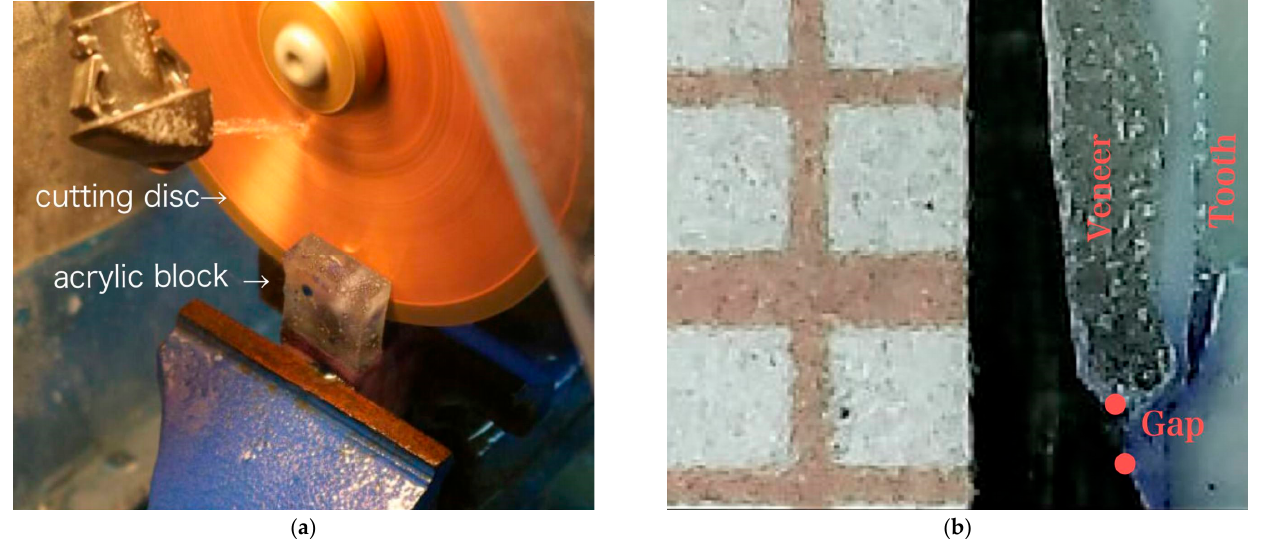
Figure 4. ( a ) Sectioning using Microtome cutter ( b ) Vertical section of veneer demonstrating marginal fit at the cervical region.